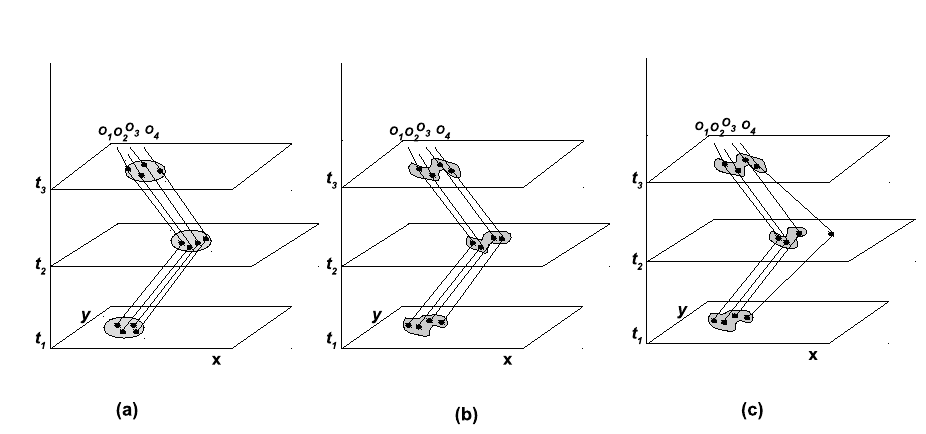
Figure 3: Examples of group pattern: (a) Flock, (b) Convoy, and (c) swarm.